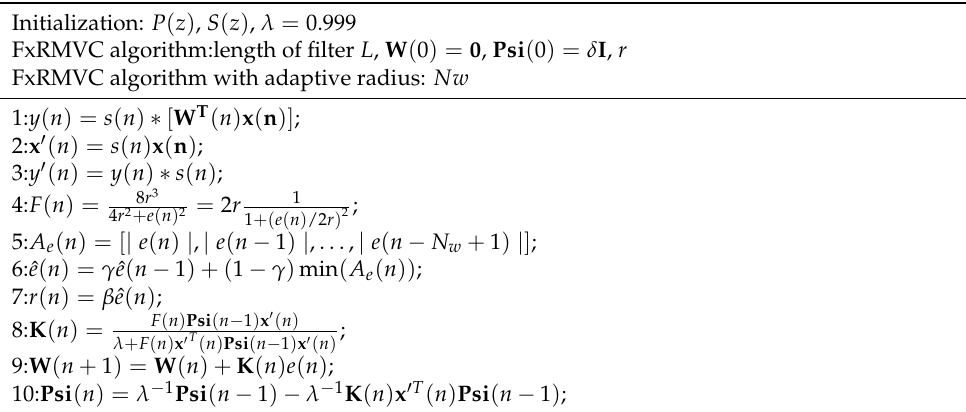
Table 1. Summary of the algorithms discussed in this paper are summarized as